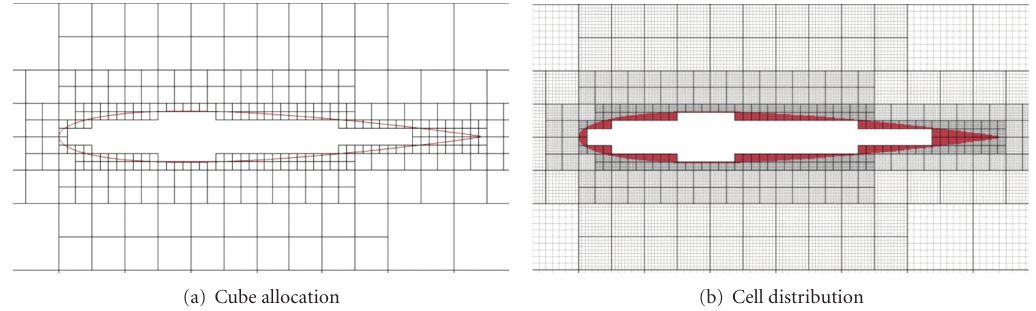
Figure 2: Cube and cell distribution around an airfoil with